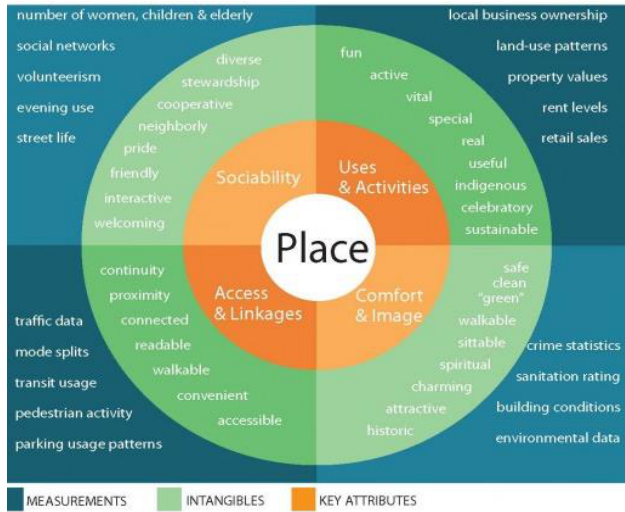
Figure 3. The Place Diagram, developed in the Project for Public Spaces